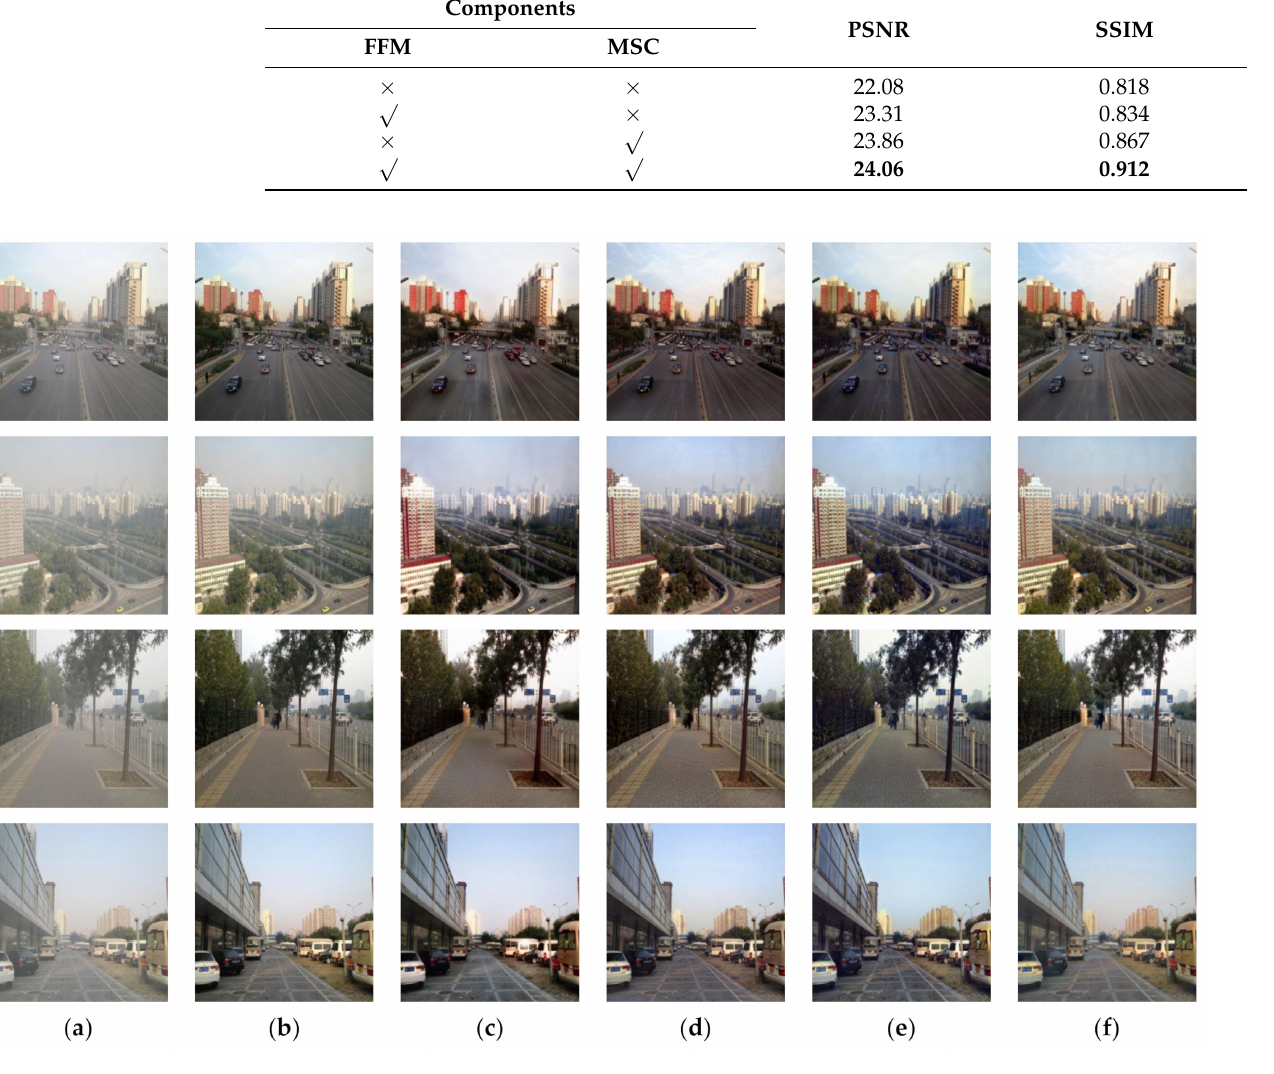
Figure 11. Visual results on the SOTS dataset: ( a ) hazy images; ( b ) corresponding haze-free images; ( c ) no FFM and MSC; ( d ) FFM; ( e ) MSC; ( f ) FFM +